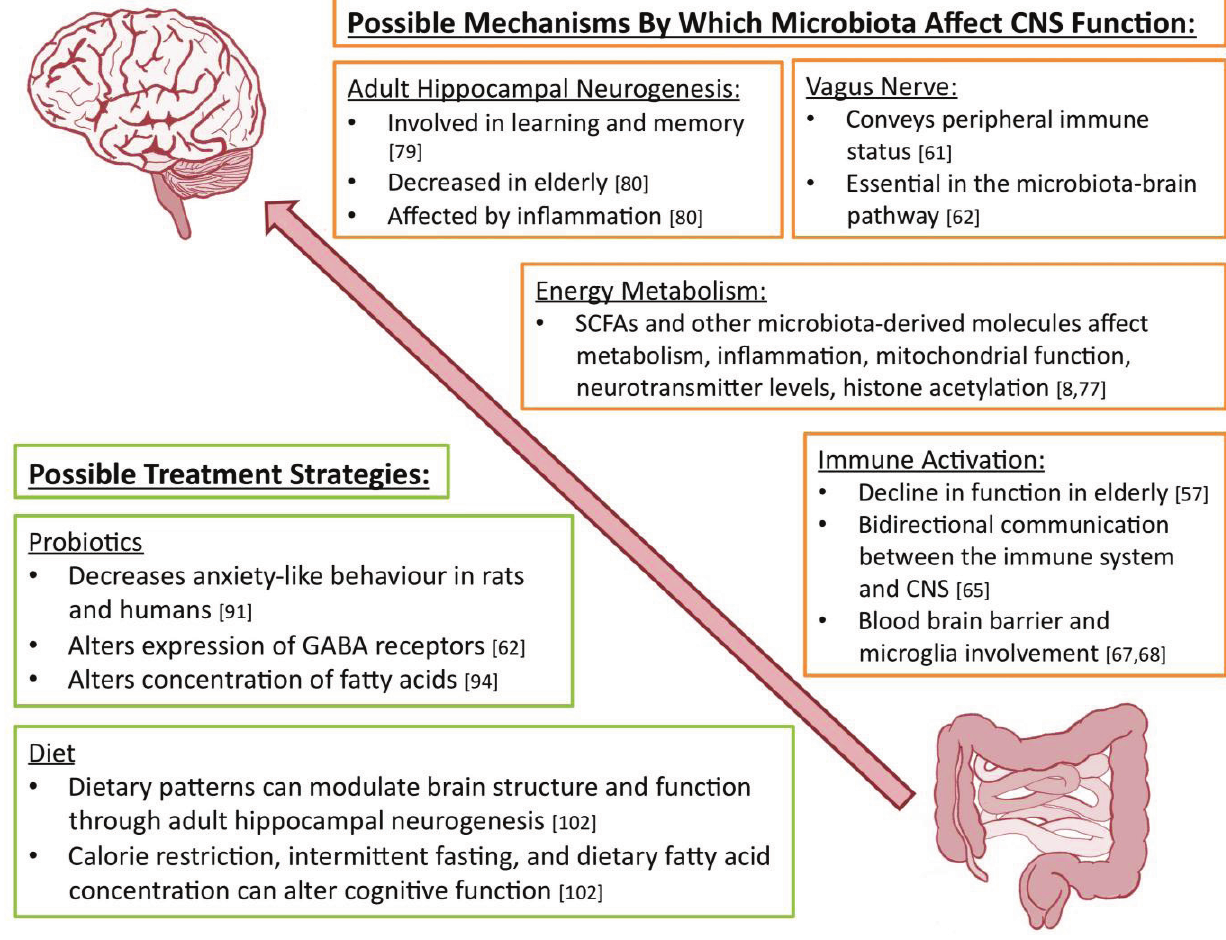
Figure 1. A summary of the various possible mechanisms by which microbiota can affect CNS function together with possible treatment strategies to prevent changes in